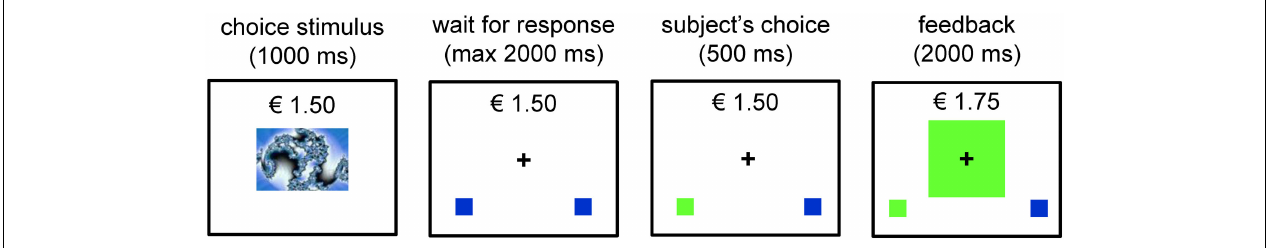
FIGURE 2 |Trial example of the probabilistic learning task adapted from Haruno and Kawato (2006a). In the example, the subject receives a reward by pressing the left button with this specific stimulus.